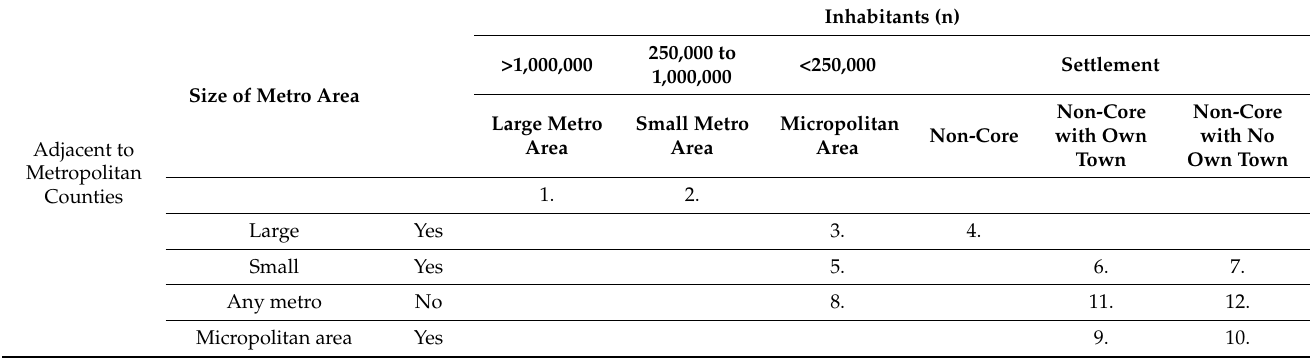
Table 4. Classification of counties according to the Urban Influence Codes, as modified by Isser- mann [203] (p. 481): criteria applied and values